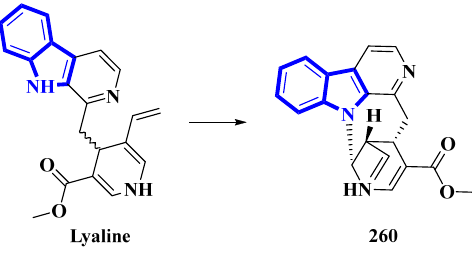
Figure 15. Revised structure of lyaline 260 .